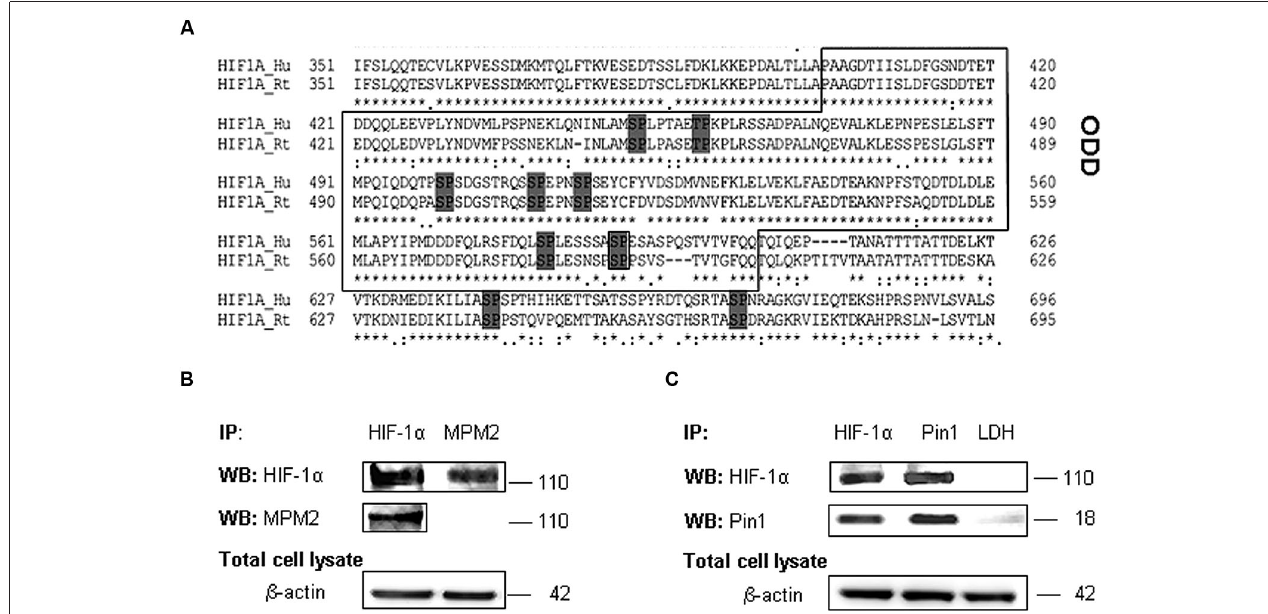
HIF-1 α and Pin1 proteins in primary rat hippocampal cells lysed in non denaturising NP40 buffer. Immunoprecipitation with LDH antibody was performed as negative control. Western blotting analysis performed on immunoprecipitated proteins showed a 110 kDa and a 18 kDa band corresponding to HIF-1 α and Pin1 respectively. Proteins detected by specific antibodies, were revealed by ECL. IP, immunoprecipitation; WB, western blot; MPM2, antibody against phosphorylated Ser/Thr-Pro